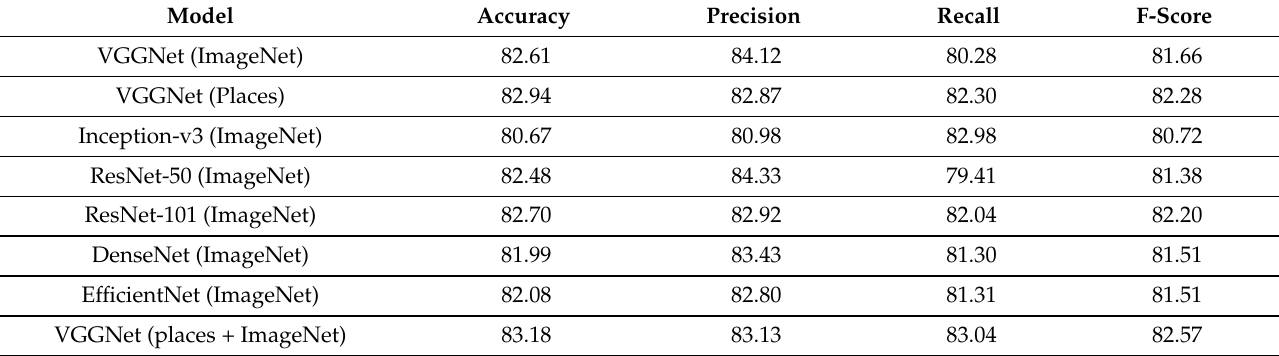
Table 7. Evaluation of the proposed visual sentiment analyzer on task 2 (i.e., multi-label classification of seven classes, namely sadness, fear, disgust, joy, anger, surprise, and neutral.